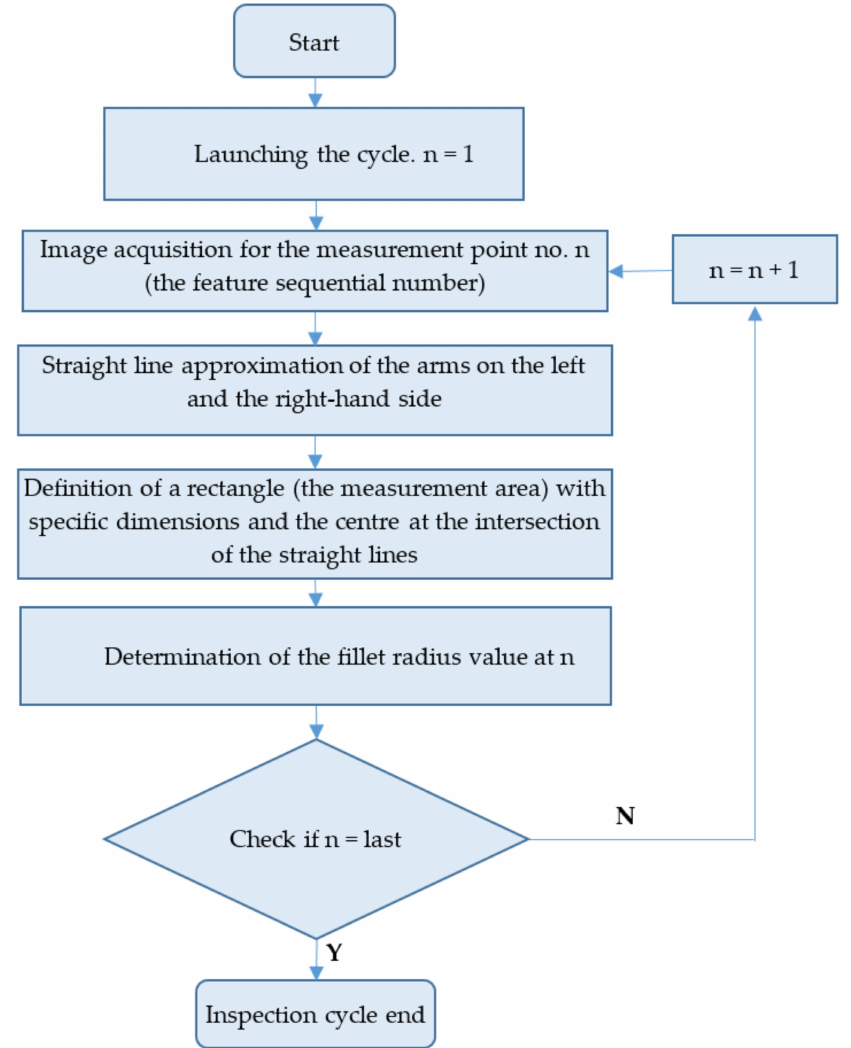
Figure 10. Fillet radius determination